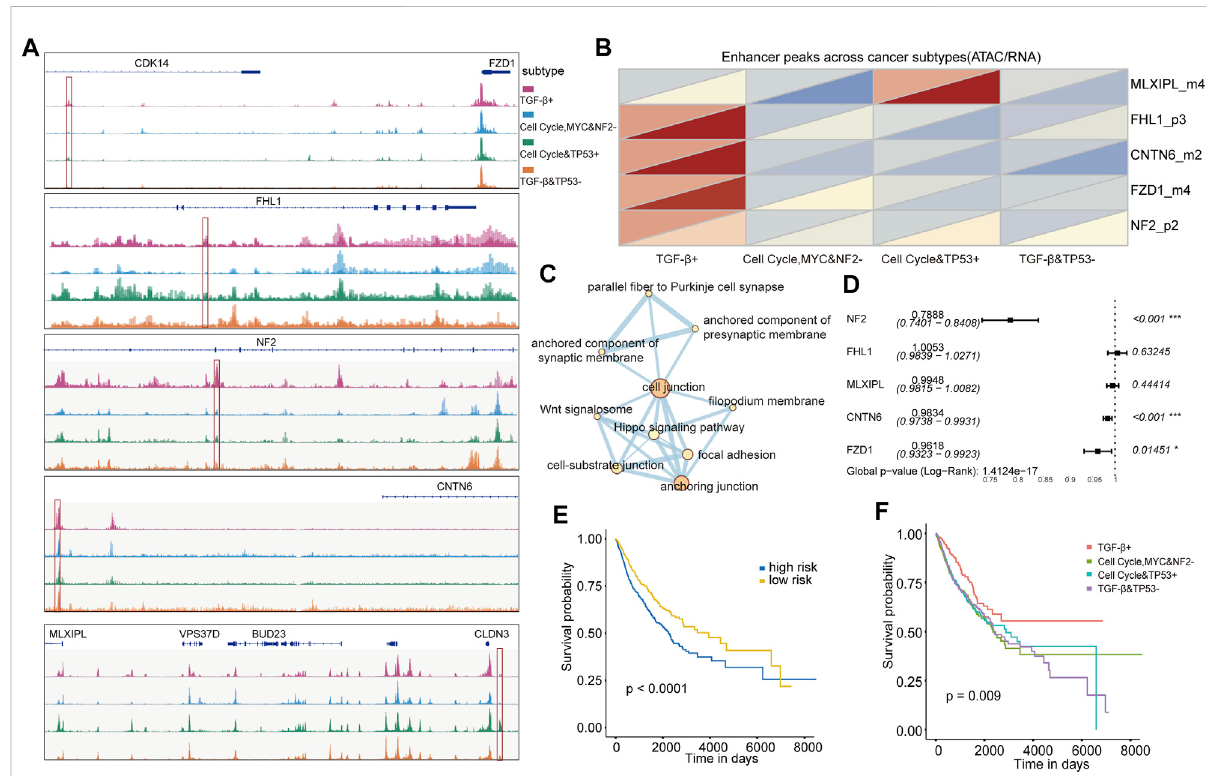
FIGURE 5 (A) FiveenhancersvisualizedusingIGV. (B) ATACaccessibility(uppertriangle) andexpression(lowertriangle)heatmapof fi veenhancer-related genes in four subtypes. (C) Pathways in which fi ve enhancers are enriched. (D) Multi-Cox risk regression model of fi ve enhancers. (E) KM survival curve for classifying the high and low risks of TCGA validation set samples was constructed by fi ve enhancers as features. (F) KM survival curve